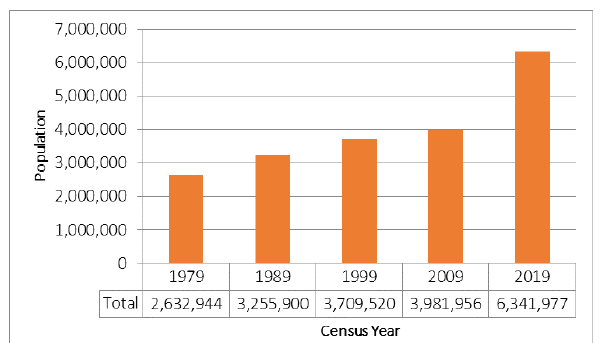
Fig. 4. Population growth in the Kenyan Lake Victoria